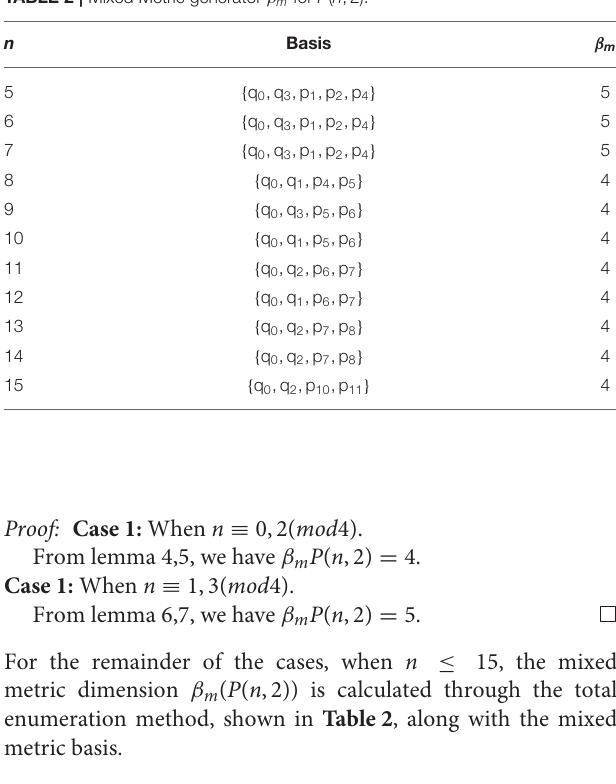
TABLE 2 | Mixed Metric generator β m for P ( n